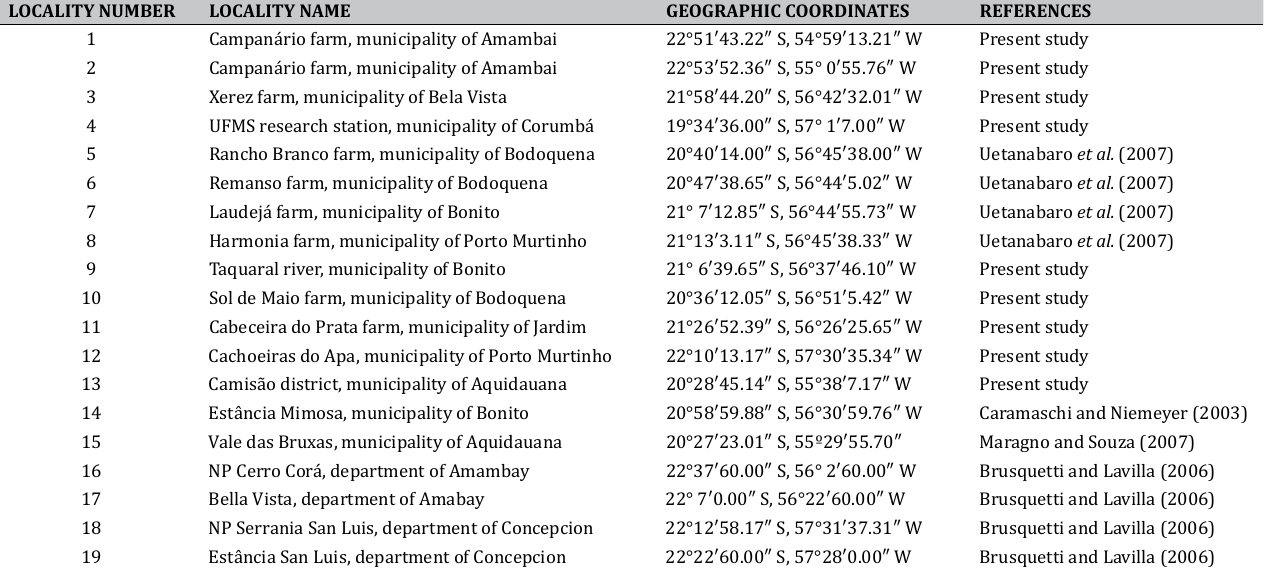
Table 1. Geographic coordinates of the 19 localities cited in